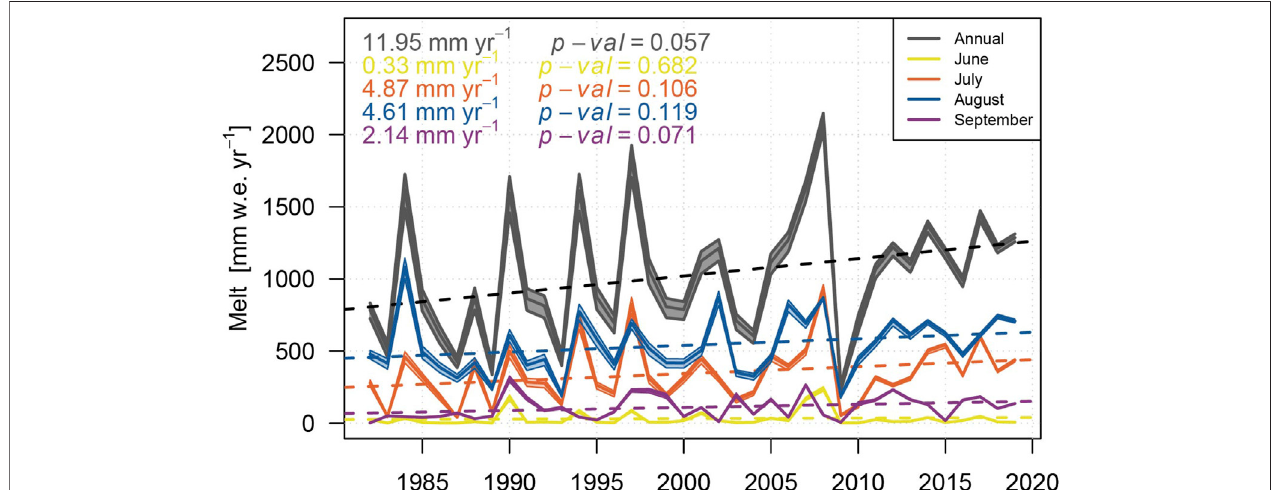
FIGURE 11 | Modelled glacier melt in the Small Naryn catchment normalized by glacier area (plain lines) and linear trends (dashed lines).